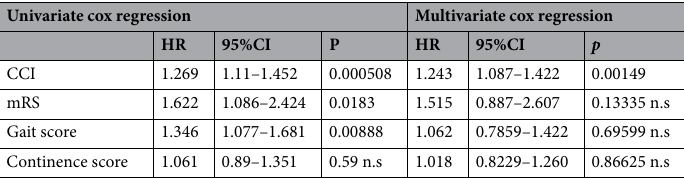
Table 3. Survival analysis applying the full scales.